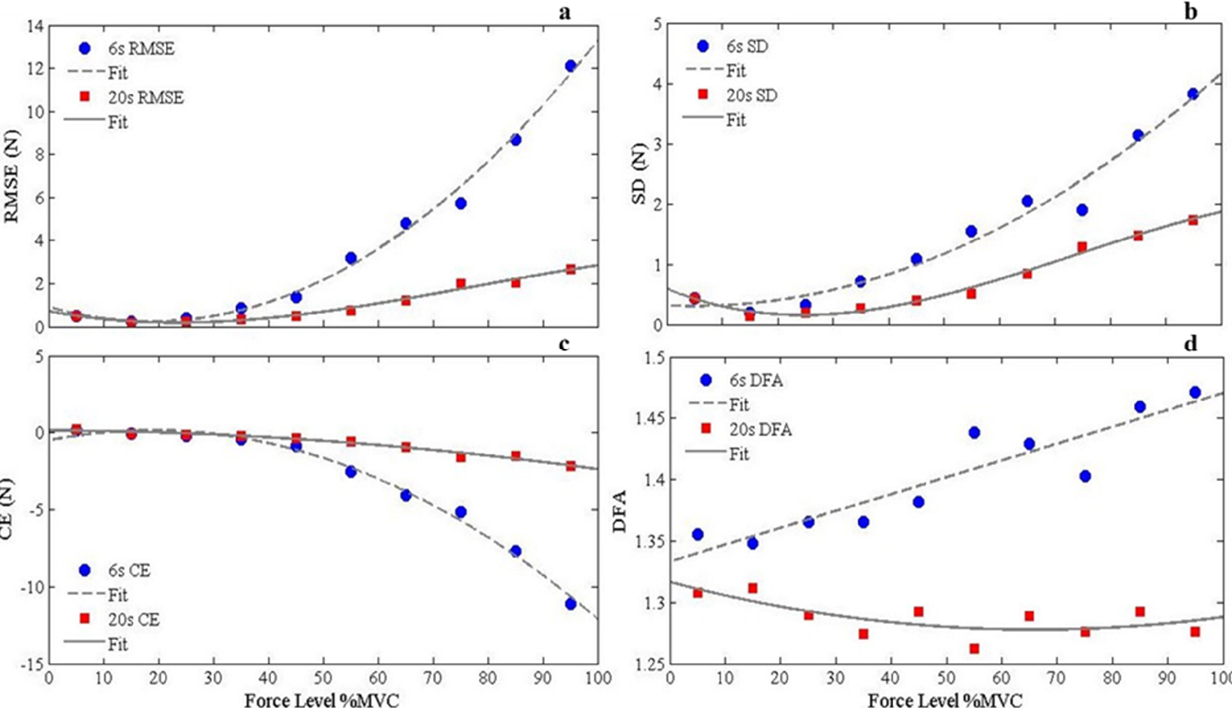
Figure 1. Illustrations of raw force data and corresponding targets at 15%, 35%, 55%, 75%, and 95% MVC in ascending order.